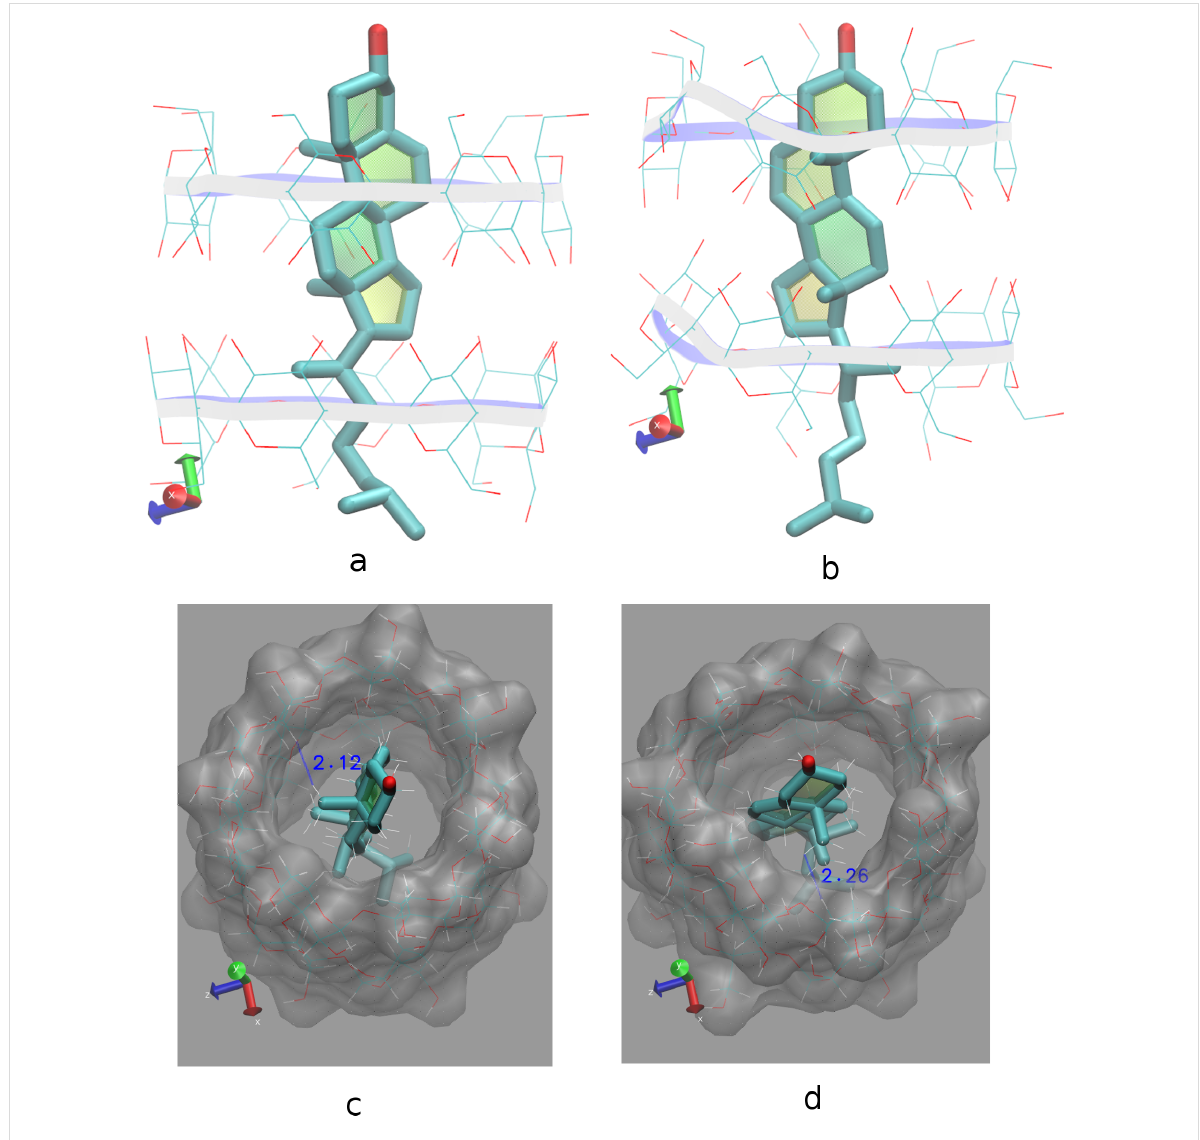
Figure 4: Representative snapshots of the CHL/ β -CD inclusion complex at 0 (a, c) and 11 ns (b, d) in timescale and at 300 K. Water molecules are omitted for clarity. (a, b) Shift of the sterol group of the CHL molecule towards the β -CD dimeric interface. (c, d) H–H interactions between CHL ring A and H5 (initially) or H3 (subsequently) of host A are retained although CHL rotates about hosts’ seven-fold molecular axes. Image rendering was ob- tained with the VMD visualization program [36].